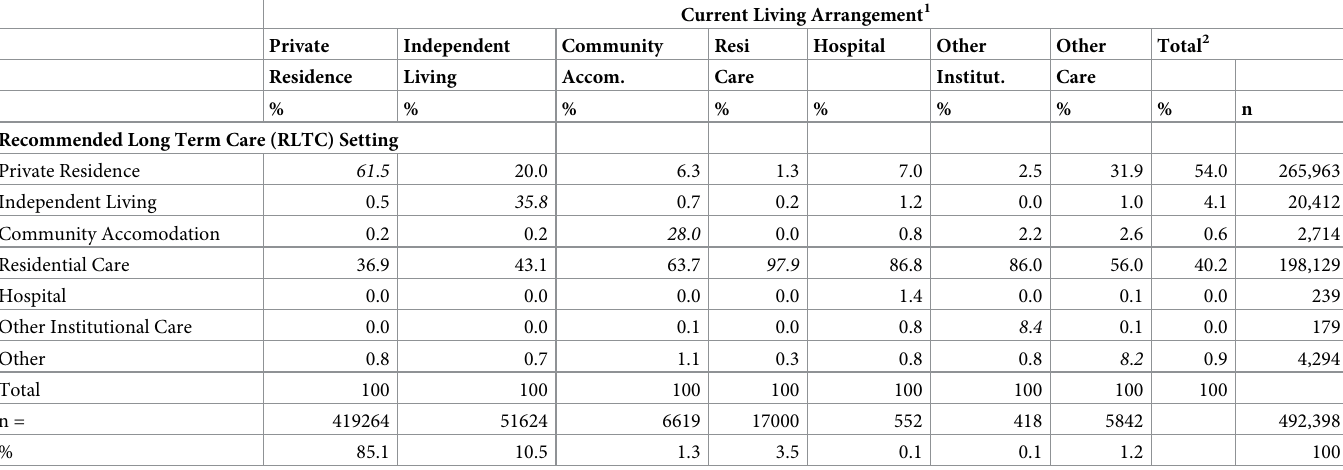
Table 3. Current living arrangement by recommended long term care setting (%),